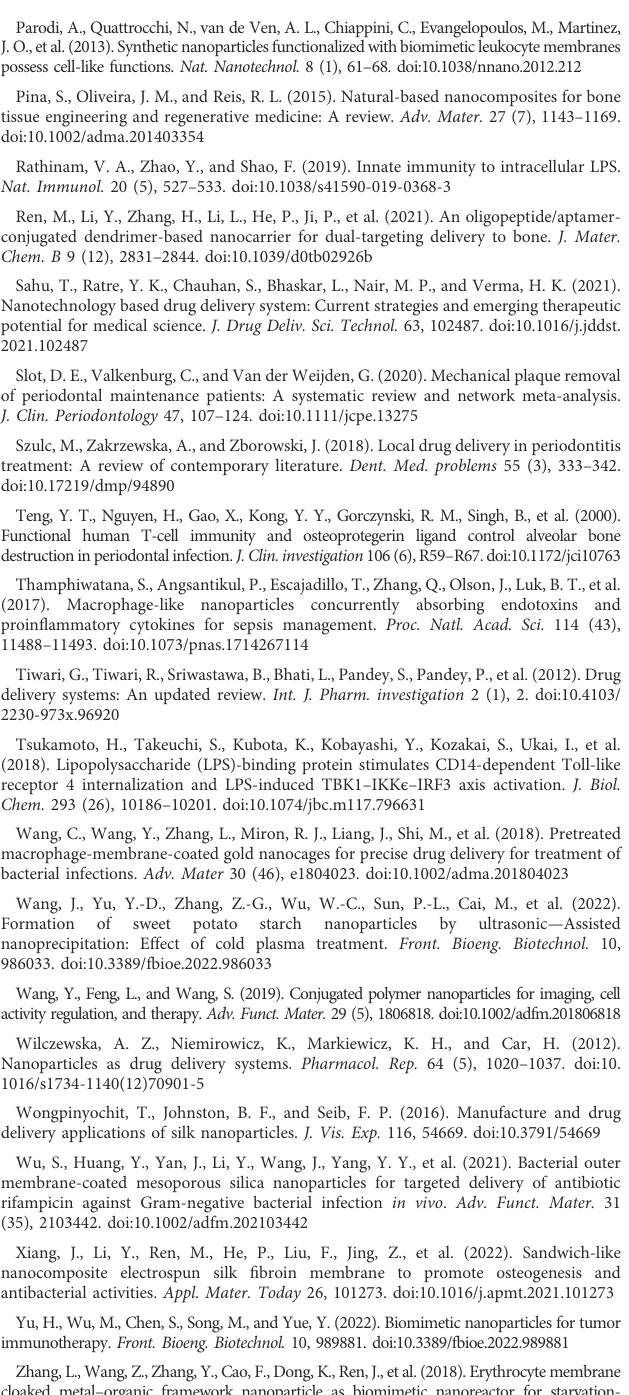
SUPPLEMENTARY FIGURE S1 Drug release pro fi les of MSNCs and E. coli-treated MSNCs from 0 h to 48 h. SUPPLEMENTARY FIGURE S2 Diffusion of MSNCs in vivo. The white curved line indicates the mouse molar; the red arrow and red curved line indicate the main green fl